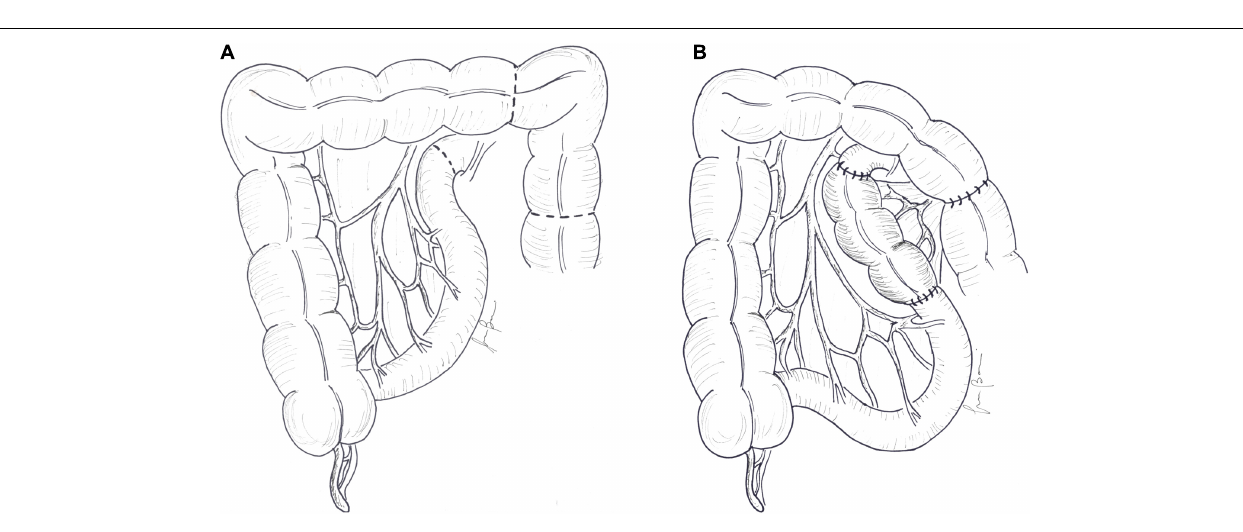
anastomosed to the distal colon. The authors created an hepato- myoenteropexy between the dilated duodenum and the anterior liver margin and the undersurface of the abdominal wall.